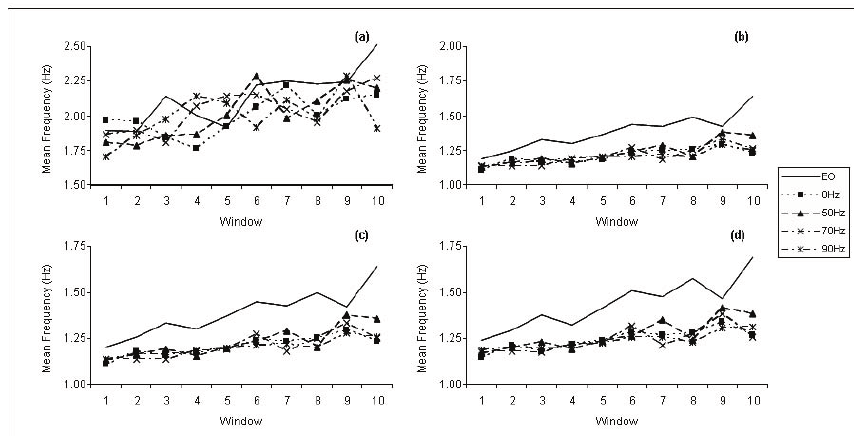
Figure 3. The effect of time on mean frequency estimation using Fourier–Bessel Expan- sion for 100-point windows (AP): (a) No window; (b) Hamming window, (c) Gaussian window ( (cid:5) D 2:5 ), (d) Kaiser window ( ˇ D 8 ).